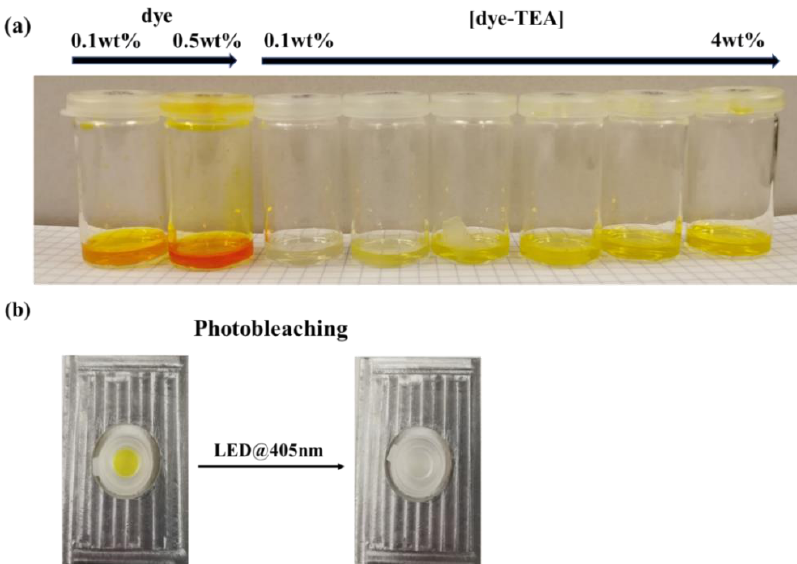
Figure 2. ( a ) Photo-images of dye (0.1 wt%, 0.5 wt%), [0.3wt%dye in Triethanolamine] (0.1 wt%, 0.5 wt%, 1 wt%, 2 wt%, 3 wt%, 4 wt%) in the monomer of PEG-DA (50 wt%)-water (50 wt%); ( b ) Photo-images of photobleaching during the photopolymerization process.